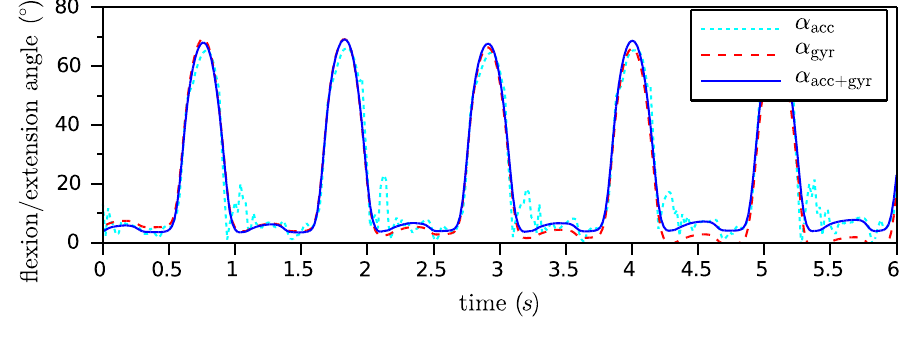
Figure 6. Sensor fusion of the gyroscope-based and the accelerometer-based knee angle of a ( t ) , is combined with the very precise, but leg prosthesis. The noisy, but driftless, angle, α acc ( t ) , using the complementary filter (15). The resulting angle, α drifting, angle, α gyr is accurate on small and on large time